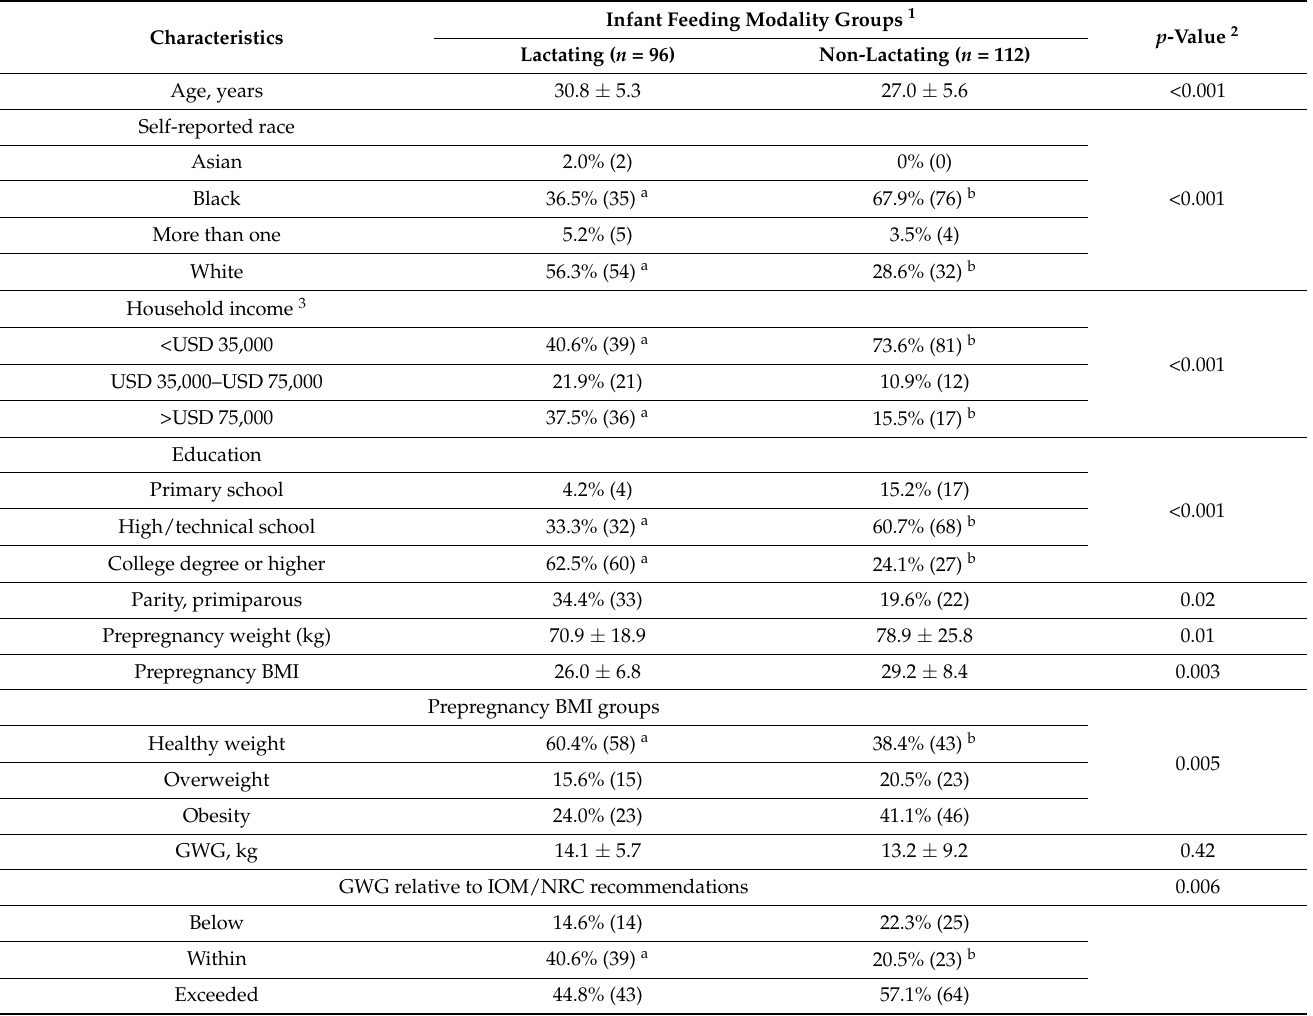
Table 1. Baseline characteristics of the study participants by infant feeding modality